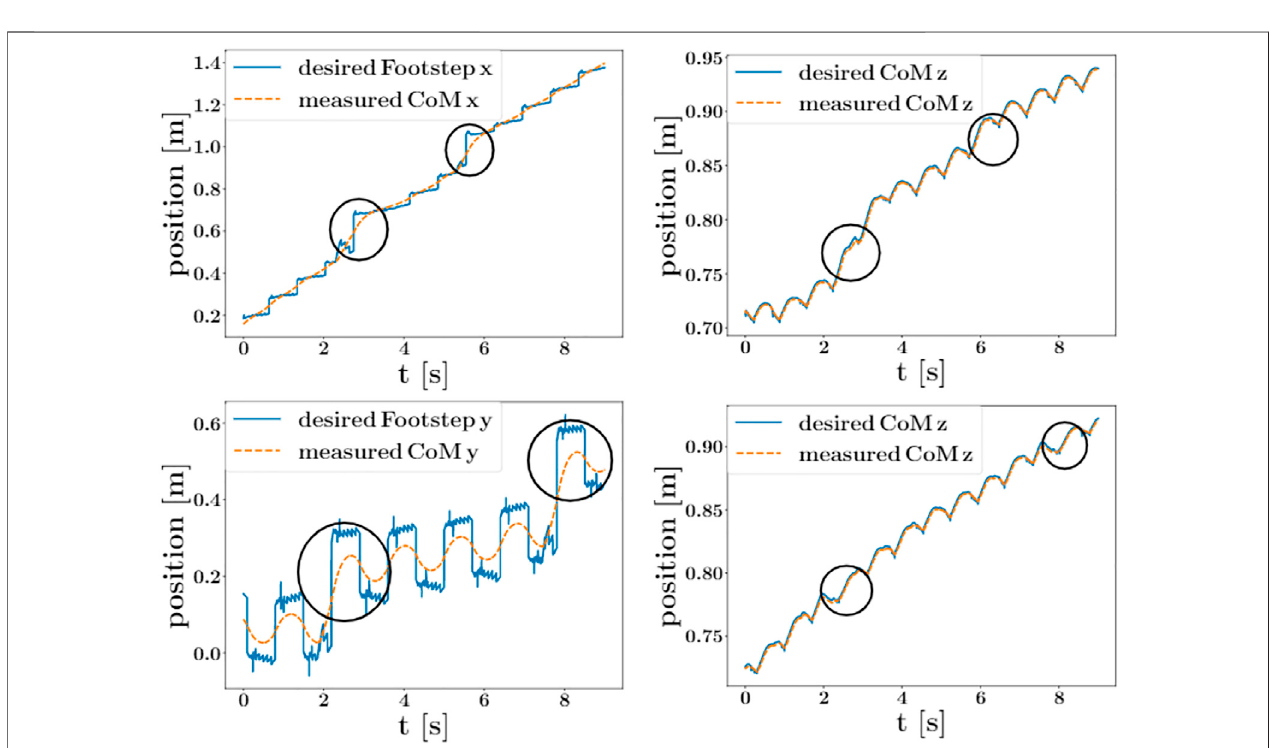
FIGURE8| Comparison betweentheproposedaSLIPplannerwiththeLIPplannerwhenwalkingona15 ° slope.Topleftisthesnapshot showingSLIDERwalking using a LIP planner; after two steps, the robot stops walking forward because LIP does not take height change into account. Top right is the snapshot showing SLIDER walking using our aSLIP planner where the robot is able to walk forward successfully. Bottom is a plot showing the comparison between the desired CoM height of LIP and aSLIP planners.